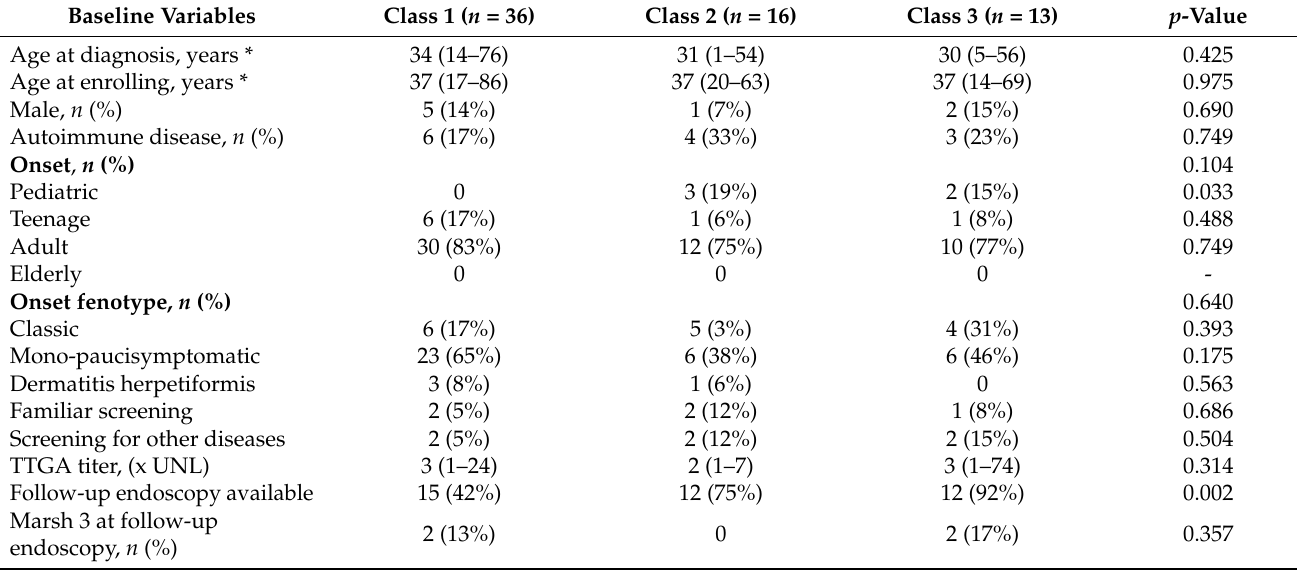
Figure 1. Workflow and distribution of patients following their tTGA trend. The first group (Class 1) of patients, composed of 36 (55%) patients, was characterized by a progressive decrease in tTGA titres during 3 (1–13) years of follow-up. Eight (22%) patients became negative after 5.6 ± 4.0 years post-CD diagnosis. The second group (Class 2, 16 (25%) CD patients) showed a fluctuating behavior during the 7 (1–26) years of follow- up. Eight (50%) patients in this class had antibody titres that turned negative at least once during the time of follow-up. In the third group (Class 3), 13 (20%) patients presented with a steady or increased titer of tTGA after CD diagnosis. The follow-up was 9 (2–19) years. All three patients with positive urinary GIP belonged to this class. The tTGA levels were not statistically different between Classes 1, 2 and 3 (Figure 2A). The clinical and demographic characteristics of the three classes of tTGA positive patients are reported in Table 2. Baseline features of CD patients with positive tTGA divided in the three